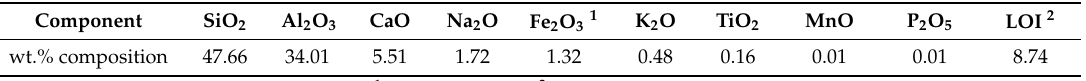
Table 1. X-ray fluorescence analysis of the untreated